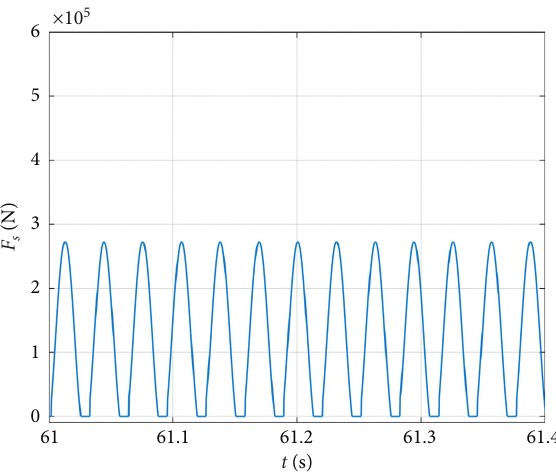
Figure 6: The contact forces F